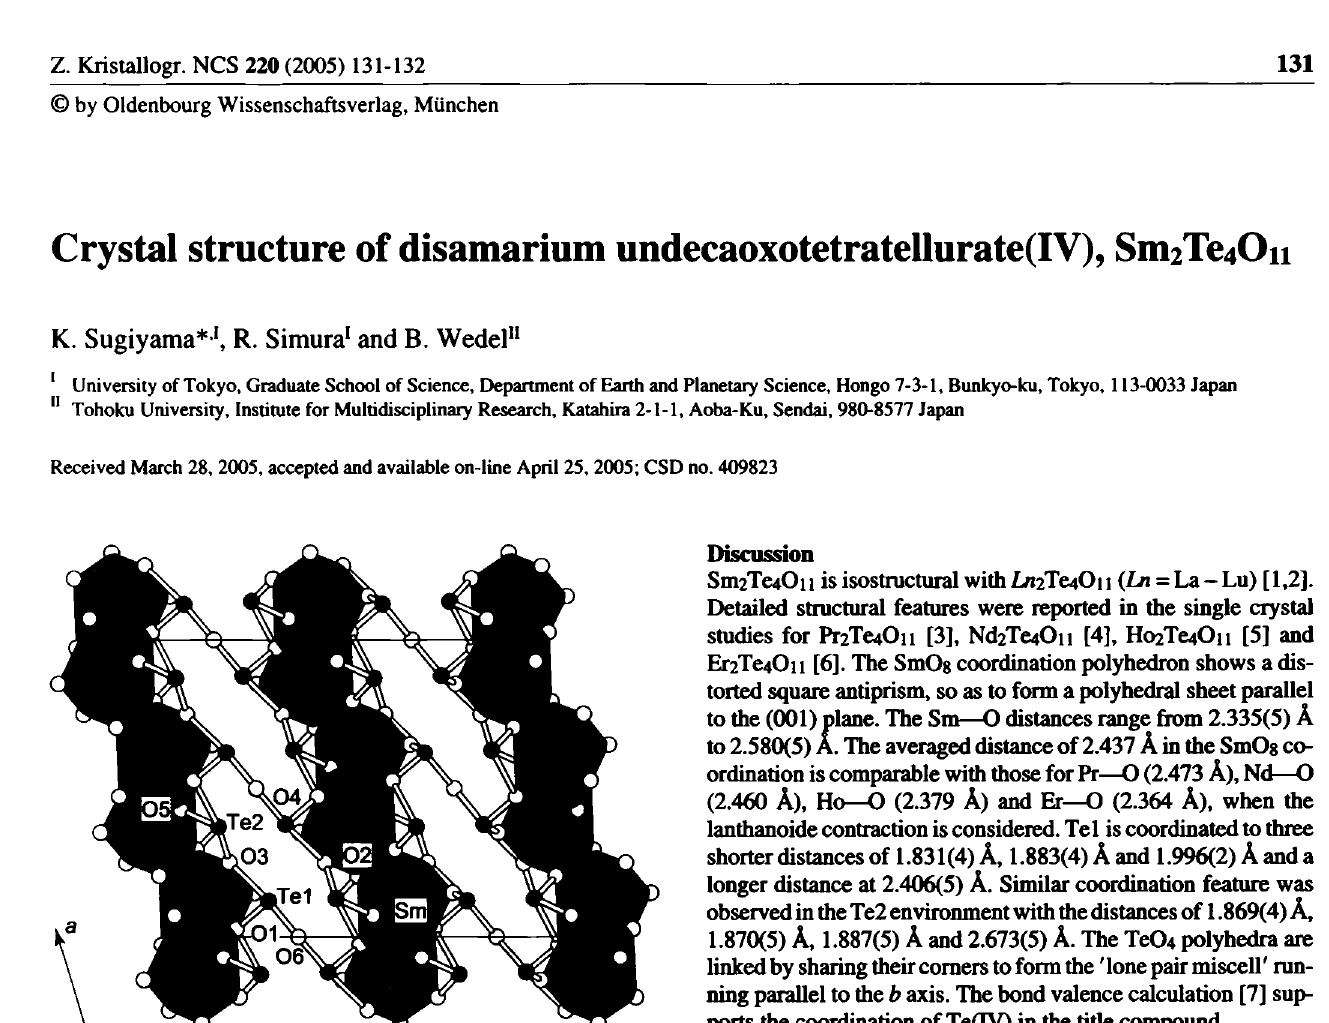
Table 1. Data collection and handling.